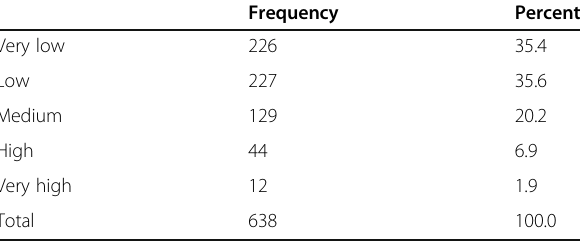
Table 3 Descriptive data on FoMO conditions in participants